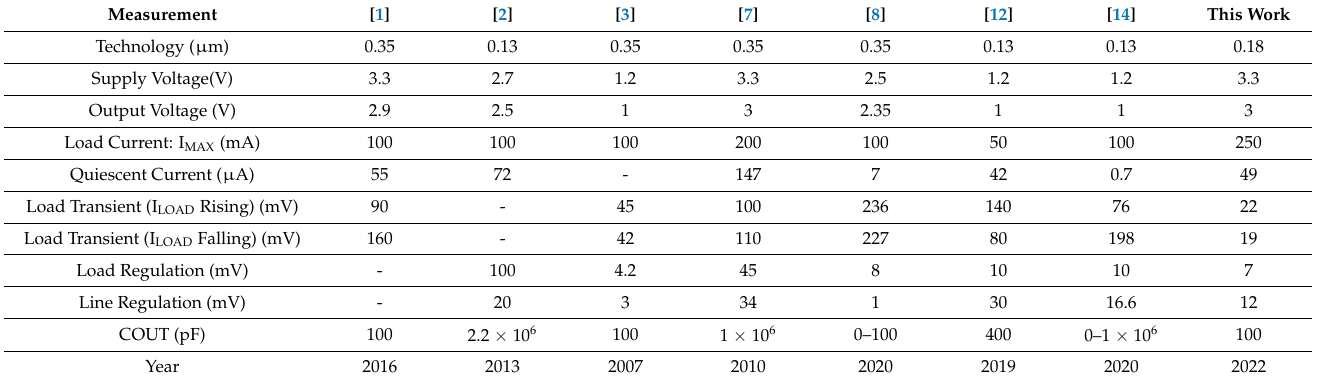
Table 1. Performance summary and comparison with reported prior